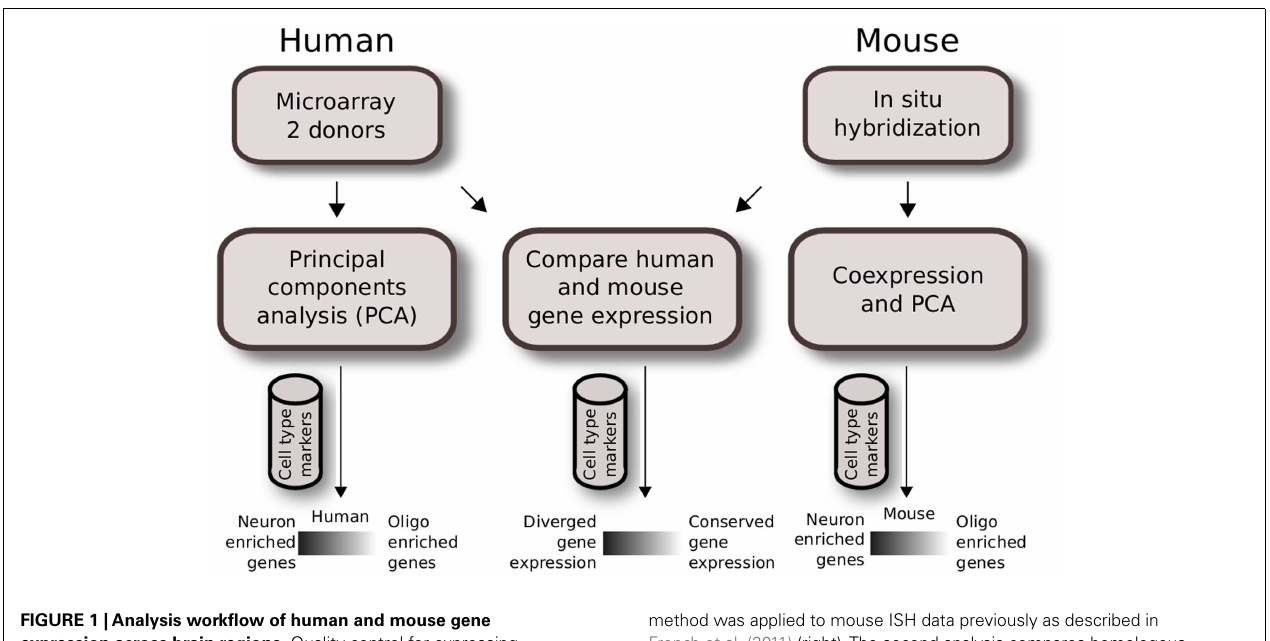
FIGURE 1 |Analysis workflow of human and mouse gene expression across brain regions. Quality control for expressing genes and gray matter tissue samples were applied prior to analysis. Regional gene expression patterns were defined using PCA for two human brain microarray data in the first analysis (left). A similar